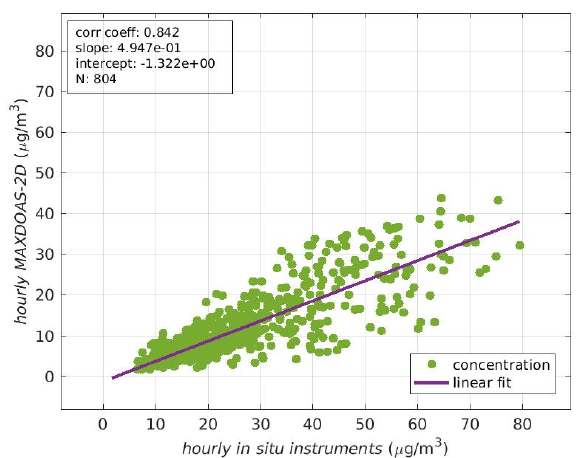
Figure 11. Correlation between in situ observations from Madrid’s air quality monitoring network and those derived from the MAXDOAS-2D instrument for the surface layer (0–200m